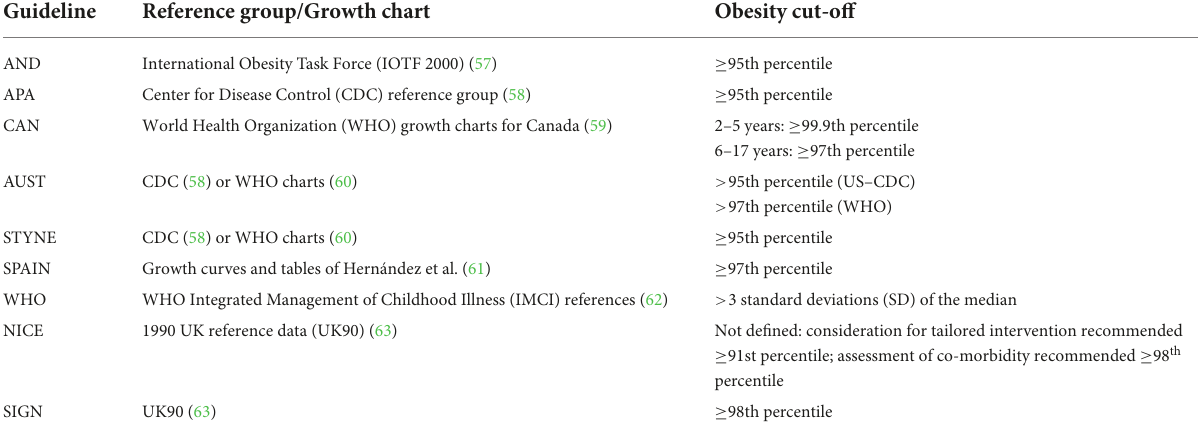
TABLE 2 Definition of obesity for children used in each included